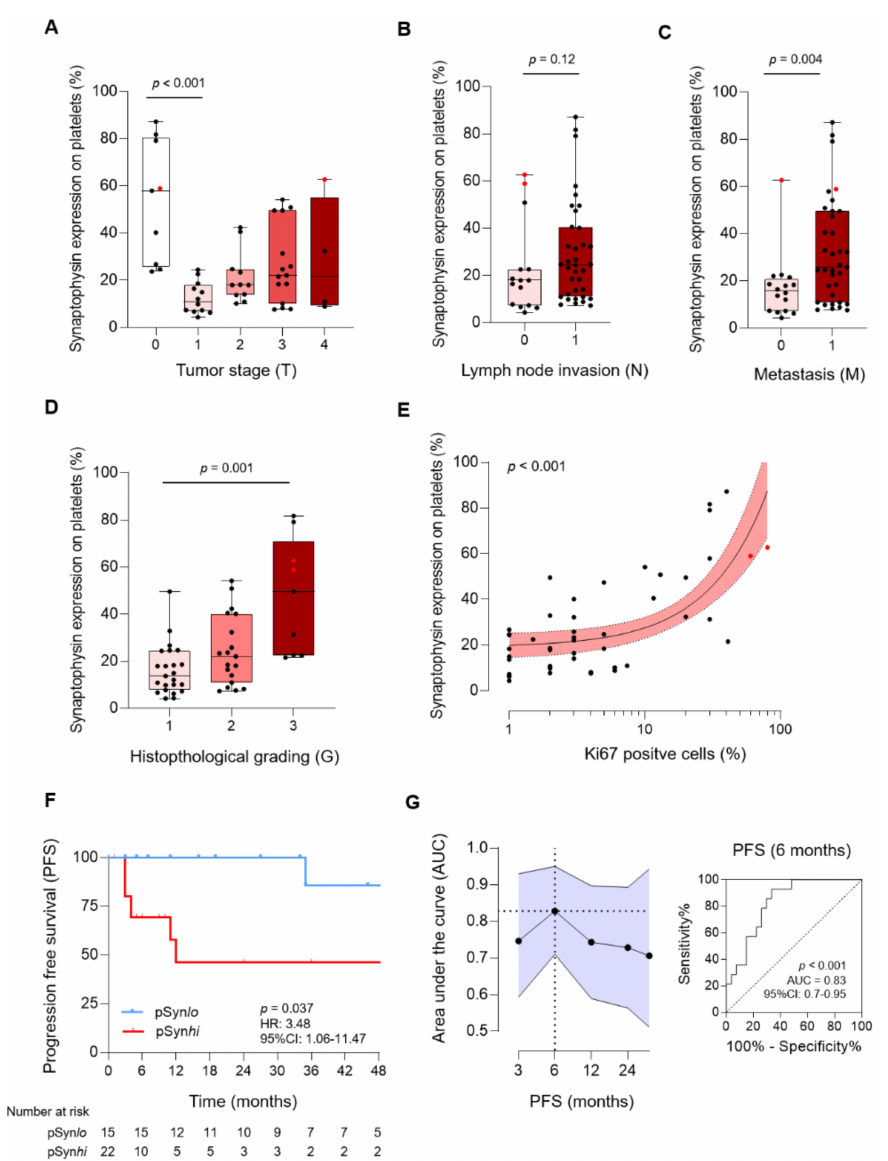
Figure 4. Associations of pSyn with tumor characteristics in NEN. ( A ) Expression of pSyn according to tumor stages (T), ( B ) lymph node invasion (N), and metastasis (M) ( C ). ( D ) Correlation of pSyn and histological grading (G). ( E ) Correlation of pSyn level and tumor proliferation (% Ki67 positive tumor cells). Line indicates linear regression, gray area 95% CI interval. ( F ) Kaplan-Meier analysis for PFS in pSyn high (pSynhi) and pSyn low (pSynlo) expressing patients. ( G ) The predictive value of pSyn expression for PFS, analyzed via ROC-analysis, is shown (black dots represent NET G1-3, red dots represent NEC G3). AUC = Area under the curve; HR = Hazard ratio; CI = Confidence interval; PFS = Progression free